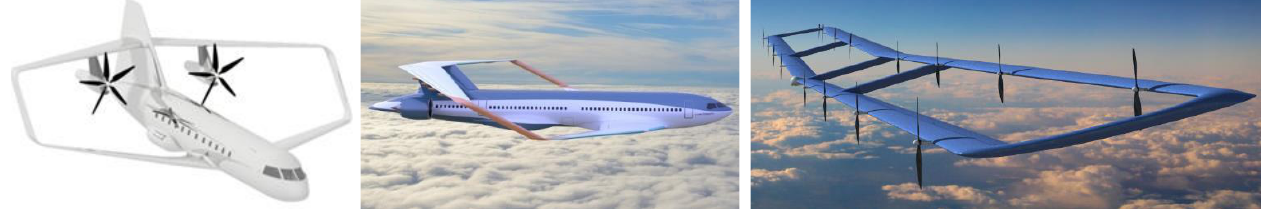
Figure 3. The box-wing architecture applied to regional ( left ), short-to-medium range ( centre ) and solar powered ( right ) aircraft.